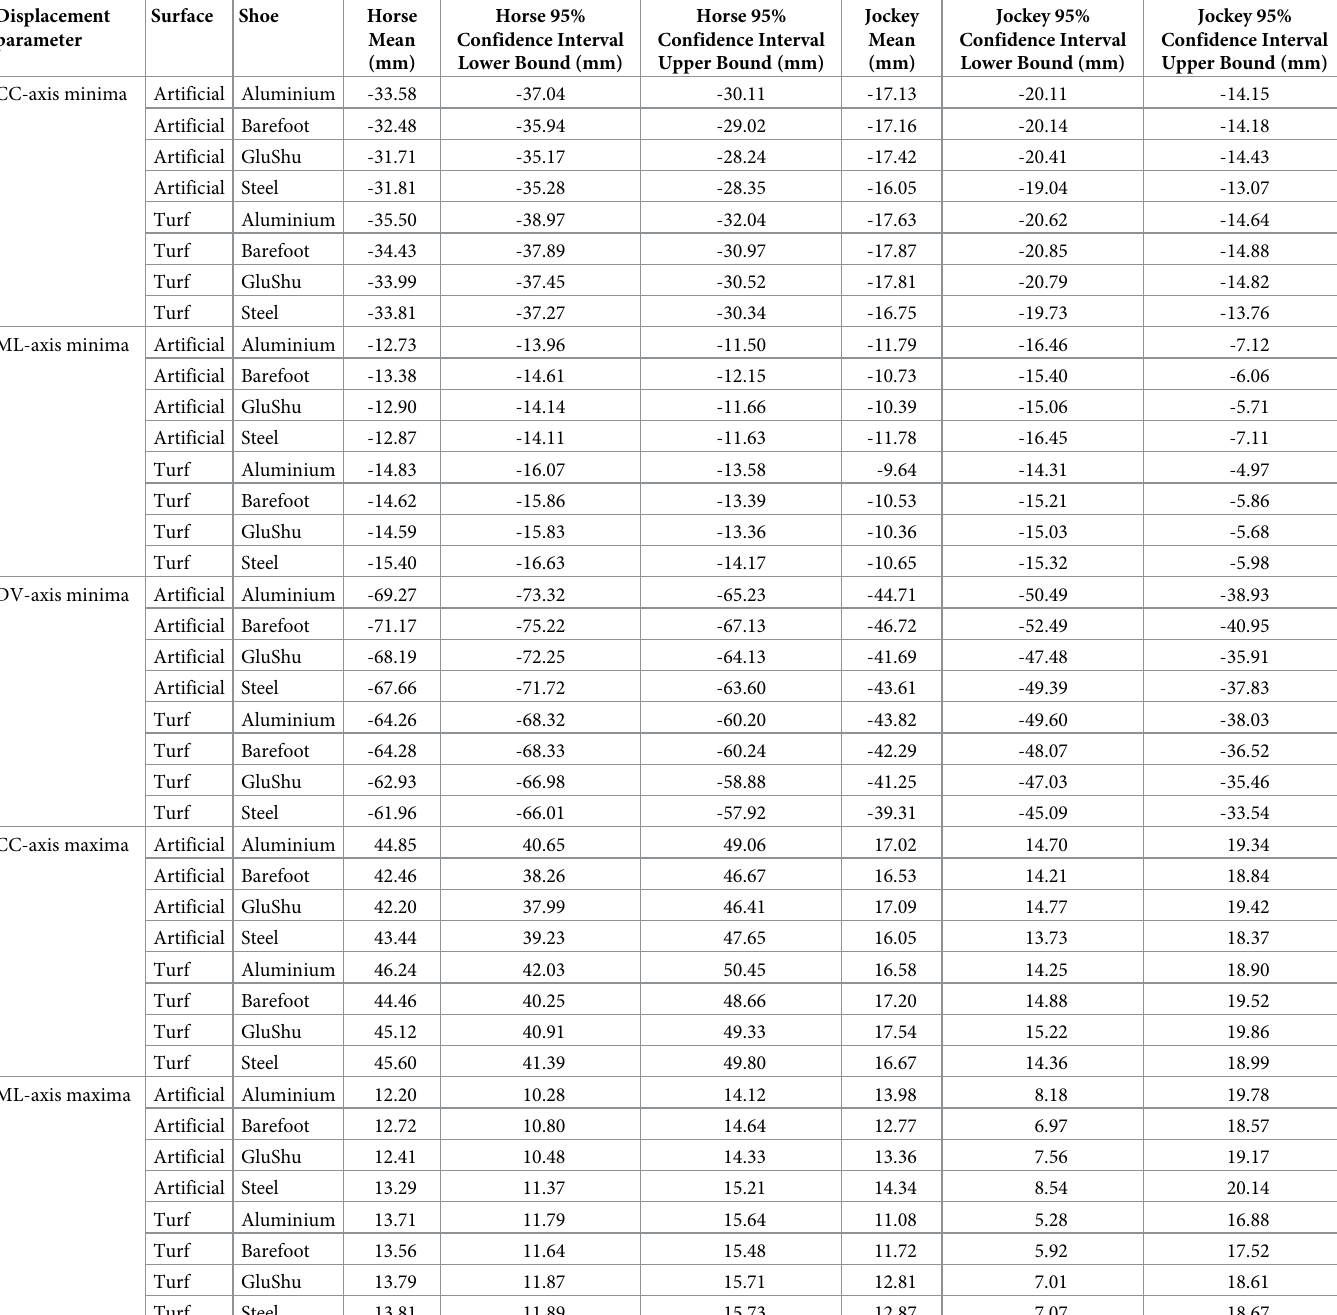
Table 5. Estimated marginal means and confidence intervals for combined shoe-surface effects. Displacement